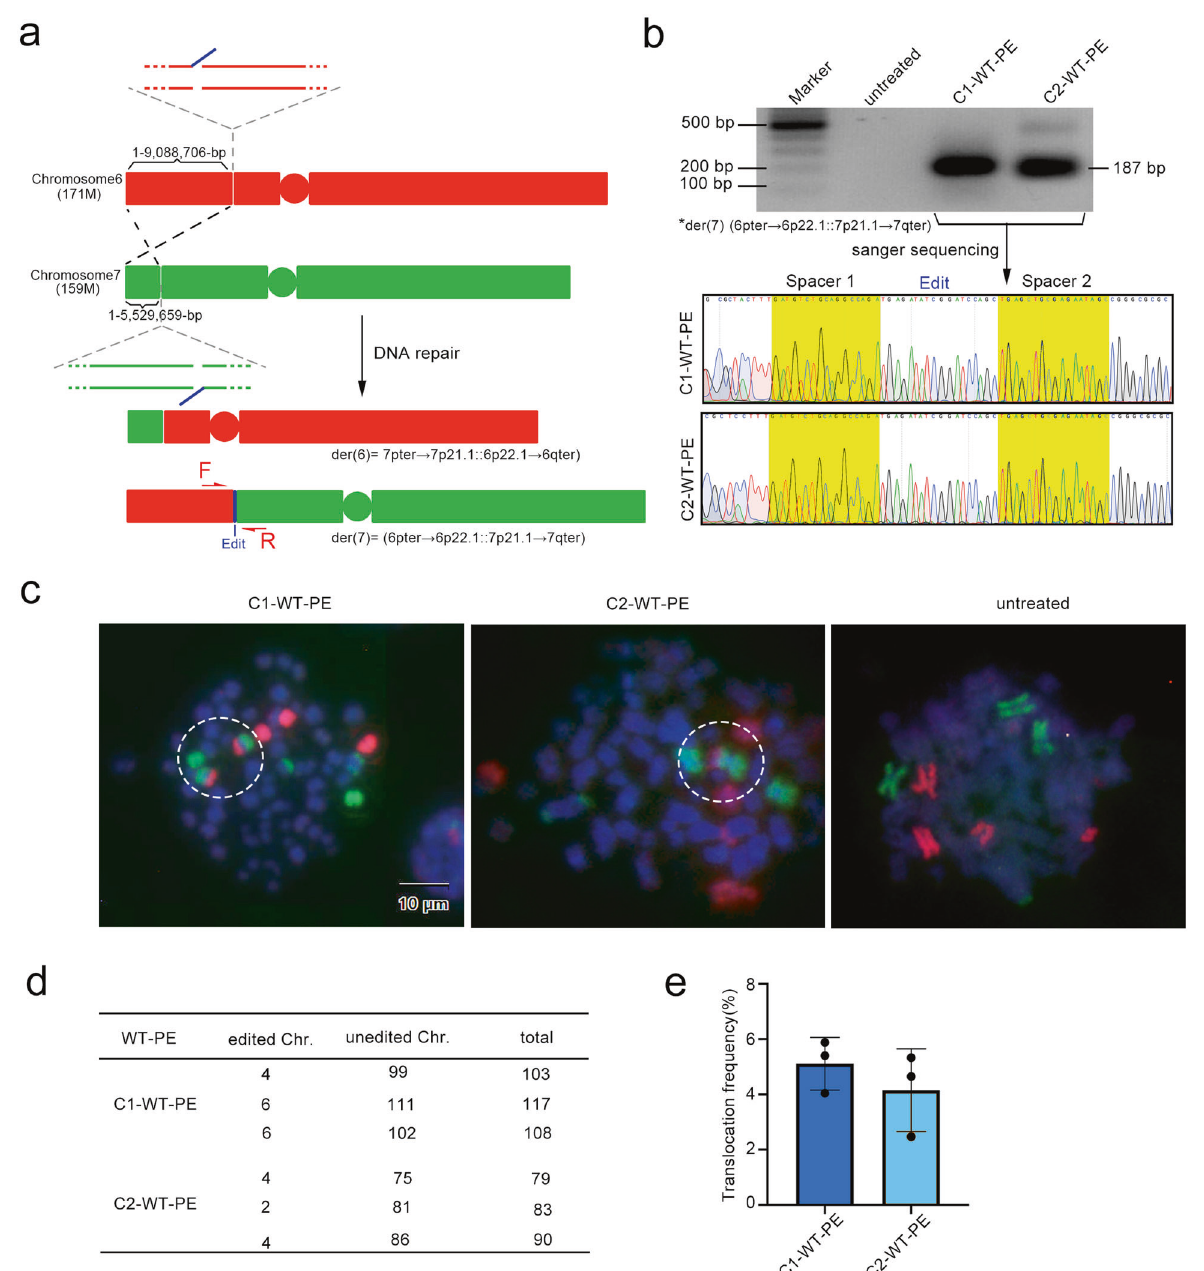
Fig. 3 Targeted inter-chromosomal translocation by WT-PE. a Diagram showing the design of translocation between chromosome 6 and 7 pegRNAs were designed to cut a 171 Mbs fragment from the short arm of chromosome 6 and a 159 Mbs from the short arm of Chromosome 7. The edits that were complementary to each were installed on the short arm of chromosome 6 and the large fragment of chromosome 7 respectively, which we expected to induce translocations of (7pter → 7p21.1::6p22.1 → 6qter) and (6pter → 6p22.1::7p21.1 → 7qter). b The presence of the translocation of der (7) (6pter → 6p22.1::7p21.1 → 7qter) was detected by PCR analysis with primers fl anking each side of the translocation. Upper panel showed the agarose gel image of the resulting amplicons and lower panel showed their Sanger sequencing chromatograms with residue spacer sequences marked with yellow. However, der (6) (7pter → 7p21.1::6p22.1 → 6qter) was not detected even with extensive PCR analysis. Primers for PCR analysis were listed in Supplementary Table 4. c Detecting the targeted translocation via FISH on metaphase cells. Two sets of probes covering the entire chromosome 6 (red) and 7 (green) were used for the FISH. Positive signals for der (7) (6pter → 6p22.1::7p21.1 → 7qter) were observed highlighted in white dotted circles. No signals for der (6) (7pter → 7p21.1::6p22.1 → 6qter) were observed. d , e Quanti fi cations of the targeted translocations. d A table summarizing the translocation events that was manually counted. e Showed percentiles of the translocation directional prime editing, resulting in ef fi cient large-scale genome introduced a double strand break (DSB) and a single 3 ′ extended fl ap in the target site, which would be integrated into the genome editing. Recently, same prime editing strategy using nuclease wild-type Cas9 has been reported to delete large genomic by endogenous repair mechanism. When WT-PE was coupled with fragment (up to ~10 kb). 26 Our work showed that in addition to paired prime editing guide RNAs (pegRNAs), it produced bi- Signal Transduction and Targeted Therapy (2022)